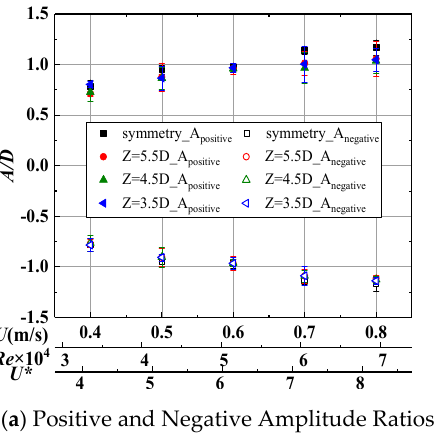
8 Figure 15. The frequency ratio ( f* ) of the PTC cylinder. 3.3.2. Energy Harvesting Characteristics Figure 16a shows the output power performance of the PTC cylinder in VIVACE when the free surface existed. The energy output power of the PTC cylinder increased with the increase of the Reynolds number at the same free surface height, and the output power could reach the summit when the incoming flow velocity was about 0.7 m/s, which corresponded with the climax of the frequency ratio in Figure 15. The motion of the PTC cylinder caused irregular fluctuations of the free surface. The randomness of the free surface fluctuation made the energy output power of the PTC cylinder change nonlinearly at different free surface heights. There were two main reasons for the difference between the simulated and experimental data: One is that the spring and damping in the